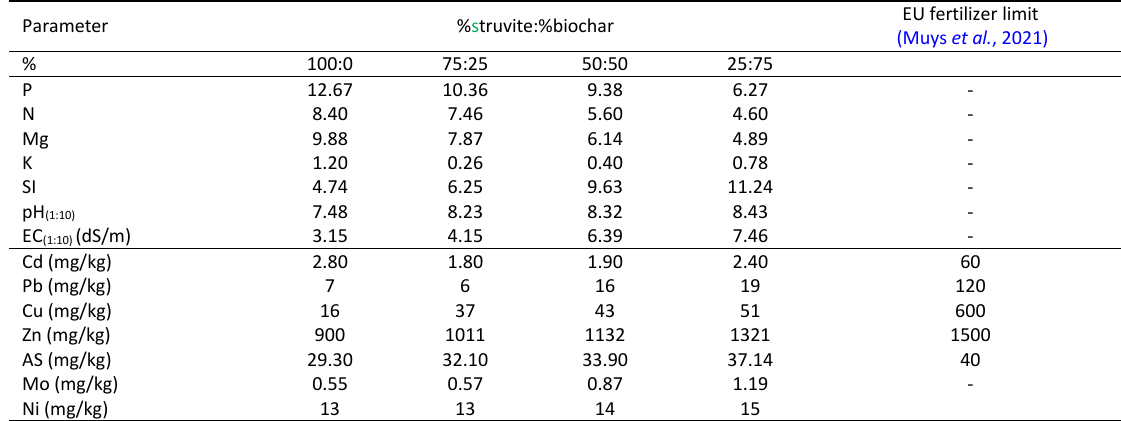
Table 6: Properties of composites (struvite: biochar) Table 6 : Properties of composi tes (struvite: bi